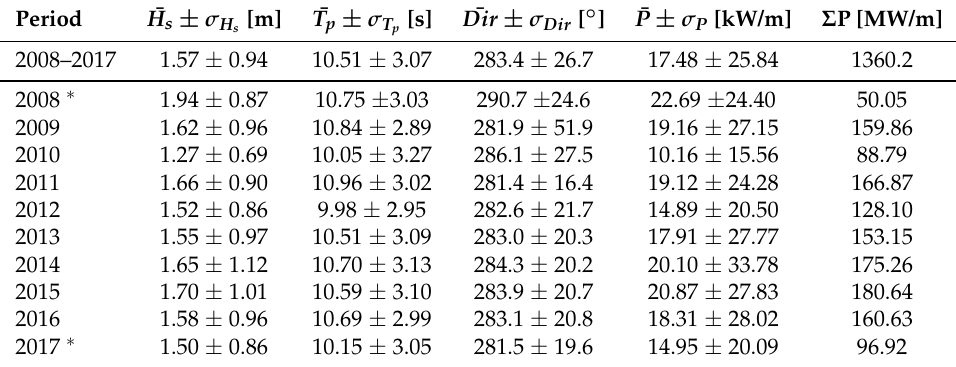
Table A1. Yearly wave statistics from 2008–2017. H s represents the significant wave height. The corresponding peak period and wave direction are respectively indicated by T p and Dir . P is the instantaneous wave power in kW/m and Σ P is the accumulative hourly wave power over the indicated time frame in MW/m. We present mean values which are denoted with¯ ± the standard deviation σ .